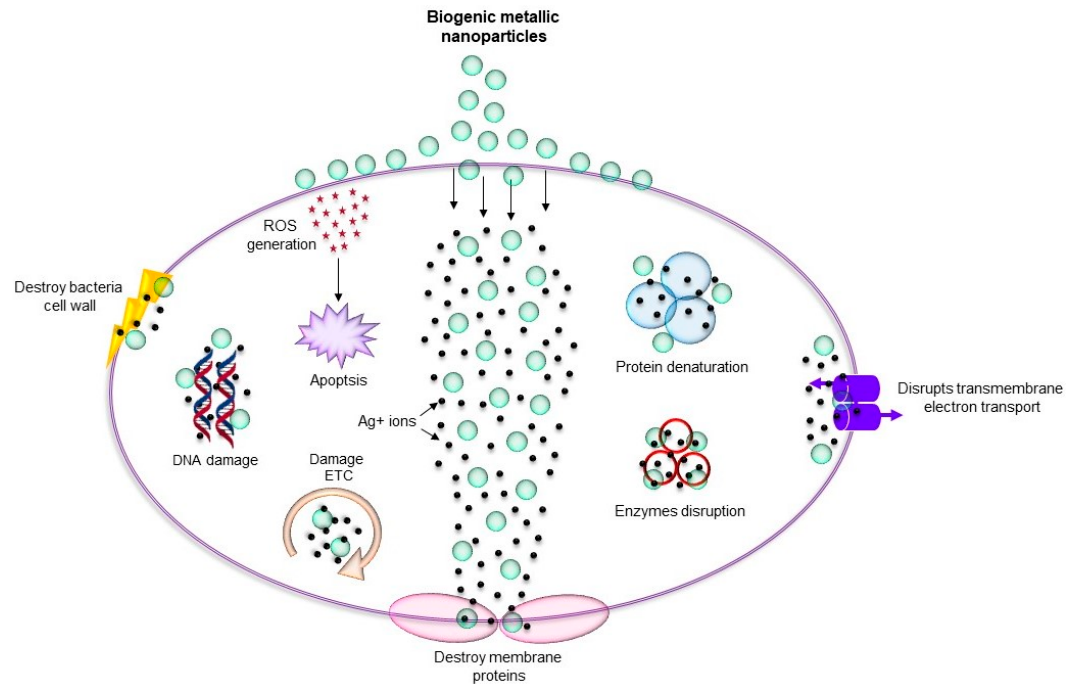
Figure 2. Various mechanism of antimicrobial activity of biogenic metallic nanoparticles. ROS: reactive oxygen species.